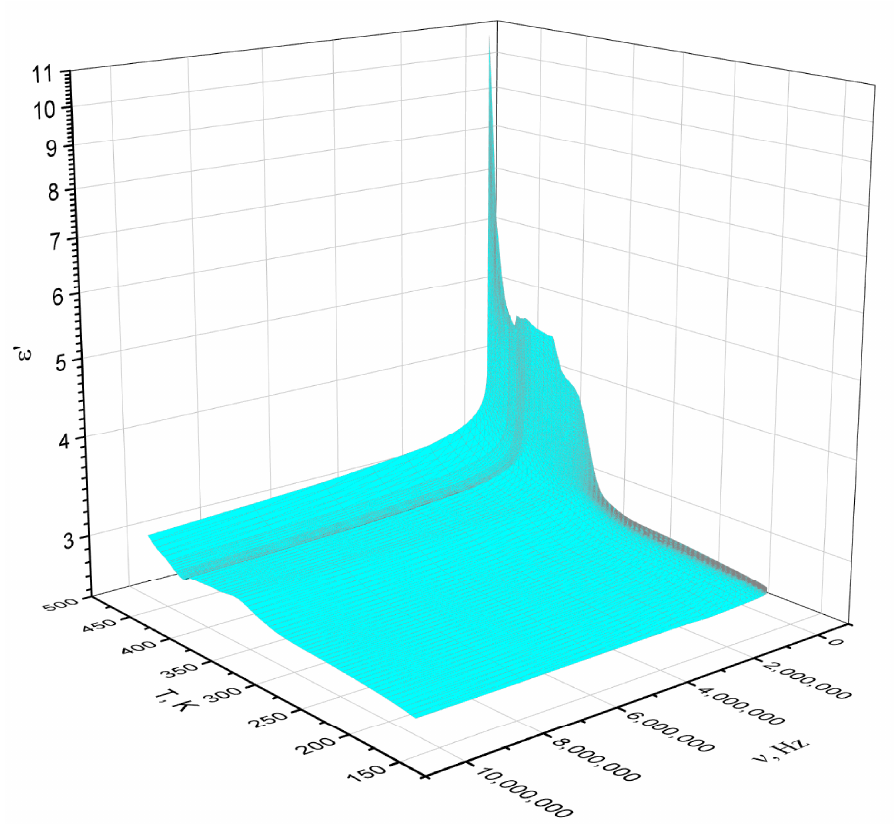
Figure 7. 3D plot of dielectric permittivity versus temperature and frequency for polyNBi.